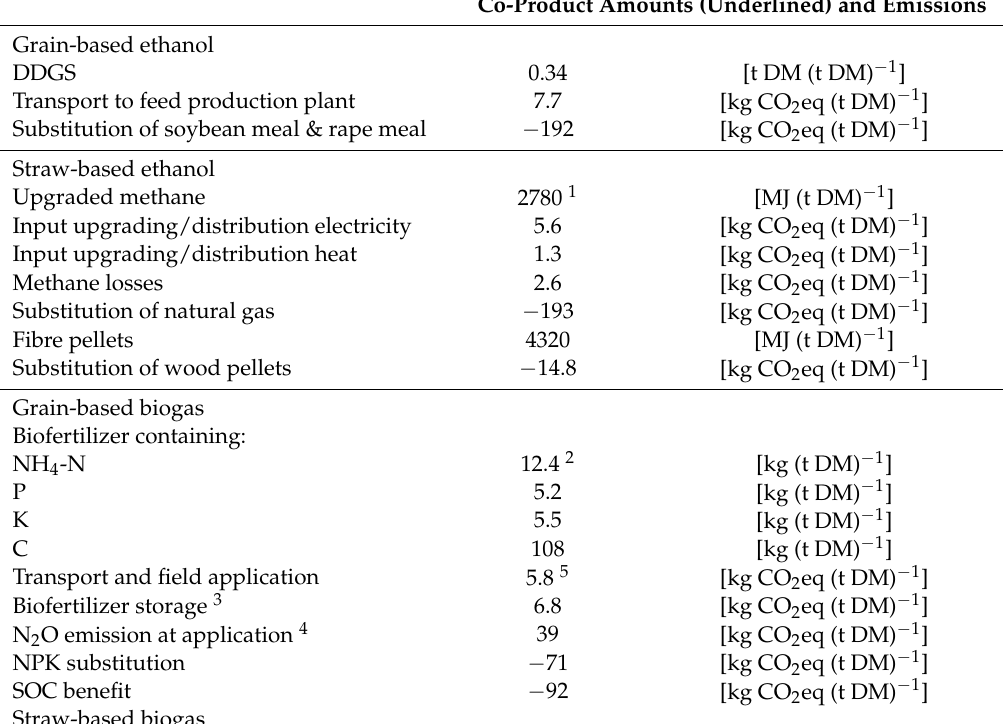
Table A18. Emissions and benefits (avoided emissions) associated with co-products at substitution per tonne DM of the original feedstock (straw or grain) added to the main process in PR1. (Negative values indicate avoided